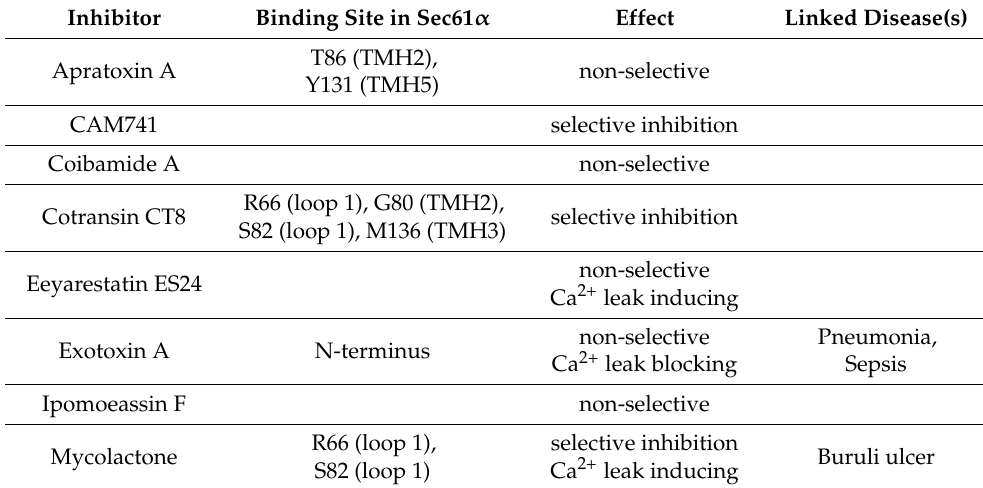
Table 2. Sec61 channel